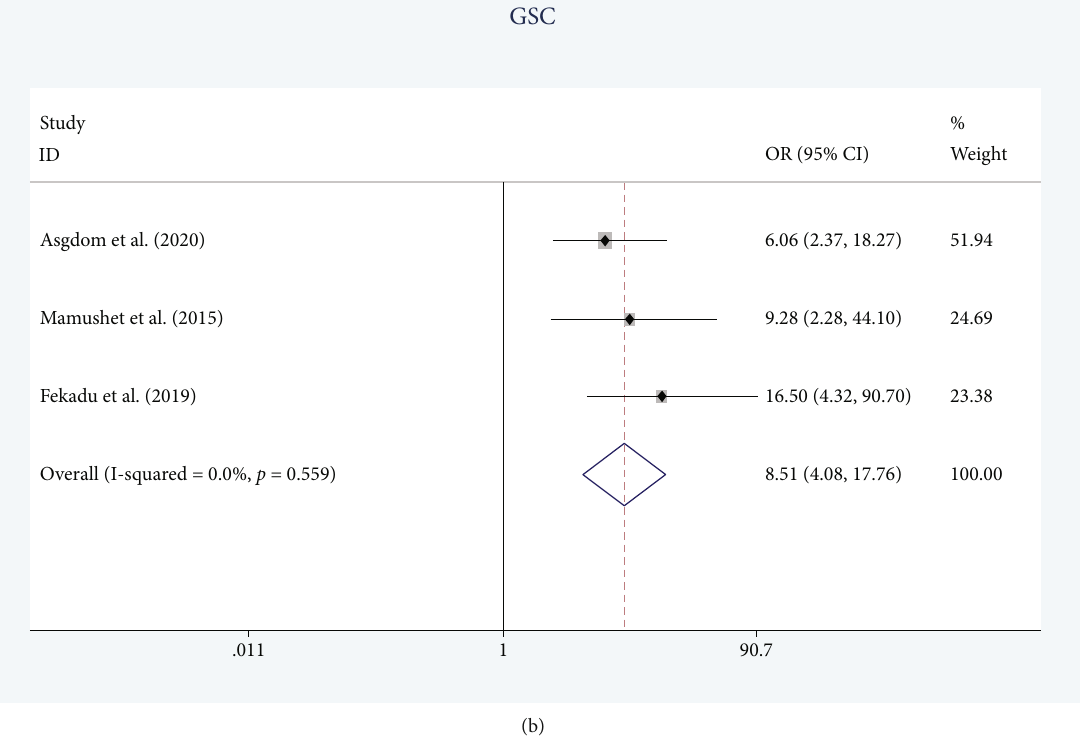
Figure 5: (a) Forest plot showing the odds of stroke mortality by sex. (b) Forest plot showing the odds of stroke mortality by GCS. Table 2: Meta-analysis of risk factors for in-hospital stroke mortality in